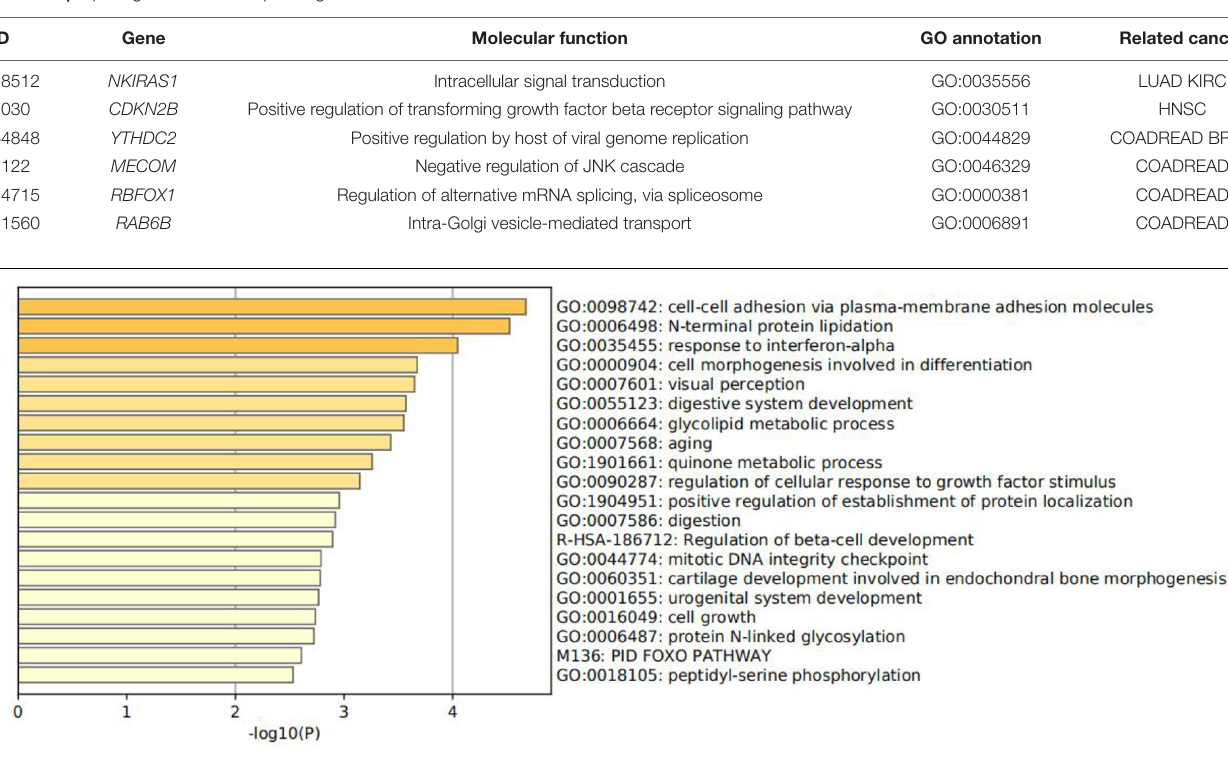
TABLE 4 | Top six genes and corresponding molecular function.